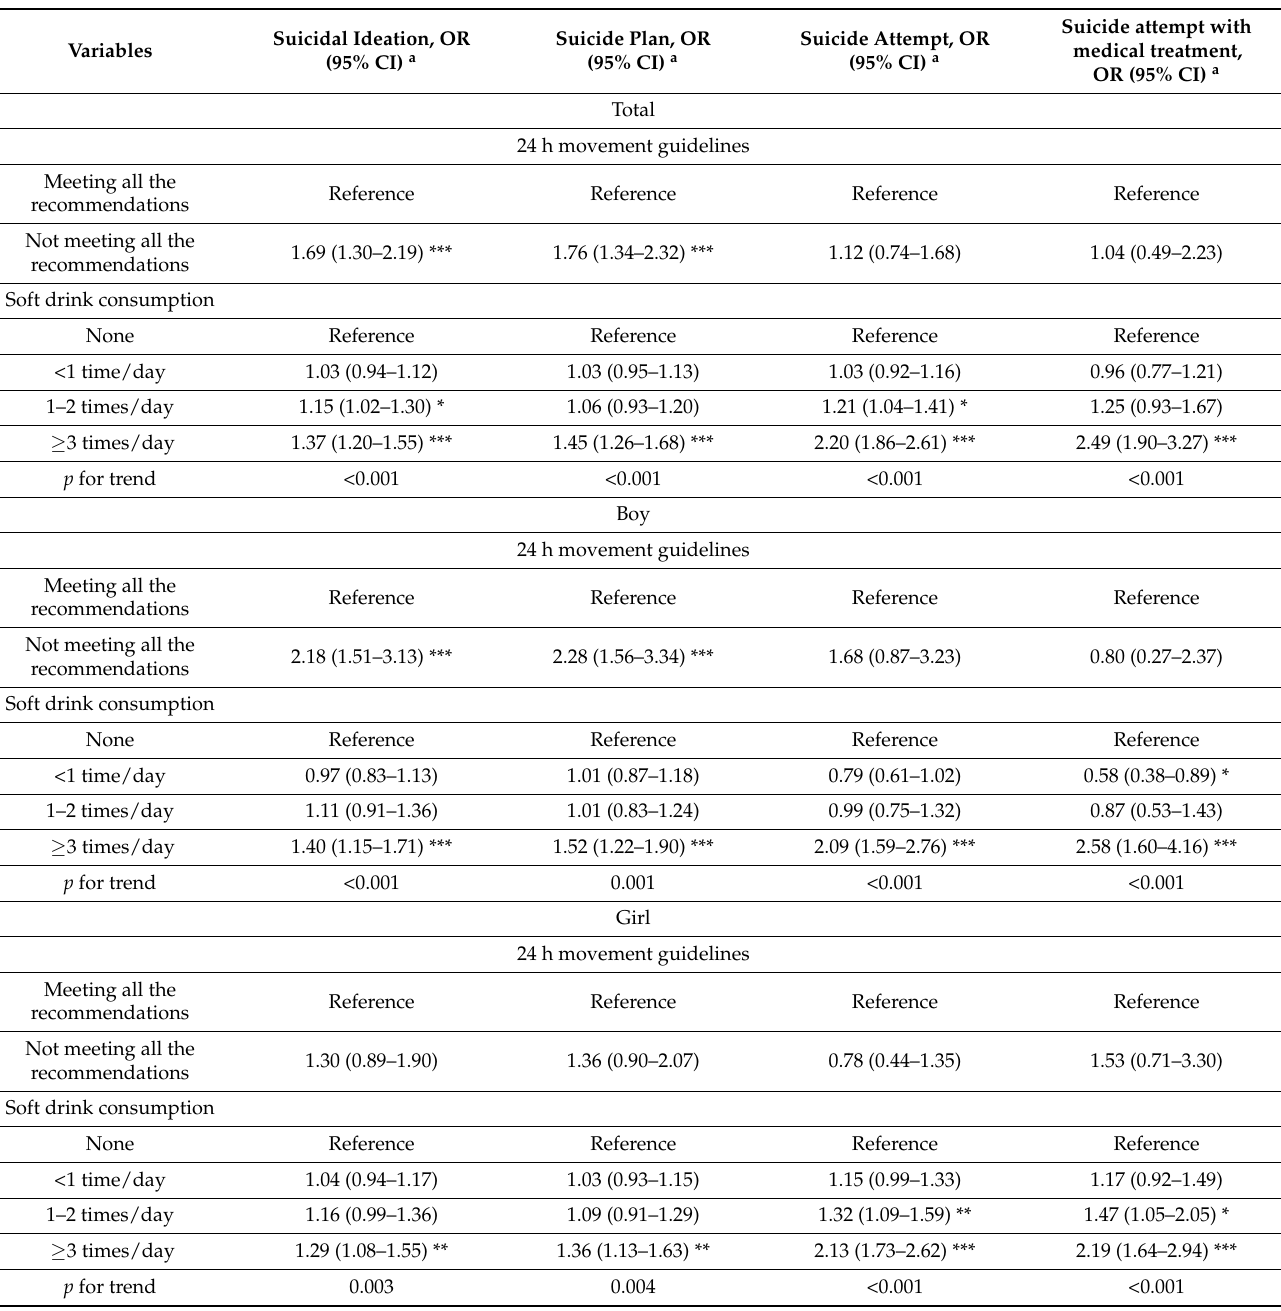
Table 2. The association of the 24 h movement guidelines and soft drink consumption with suicidality among adolescents of the